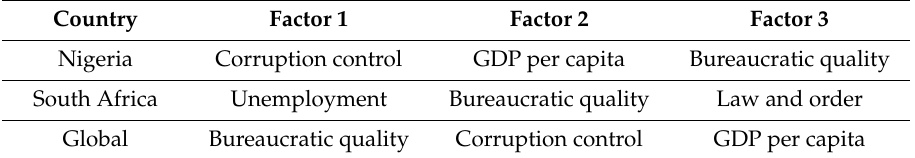
Table 2. Top three factors that determine the size of the informal sector by countries